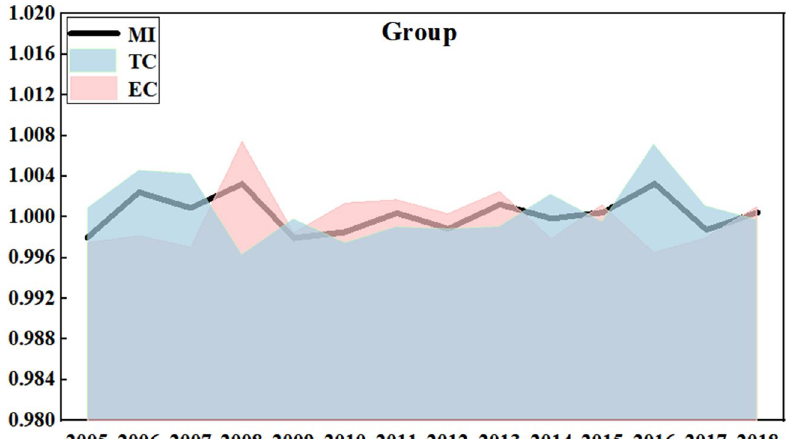
Figure 2. LHG and its decomposition index under group frontier from